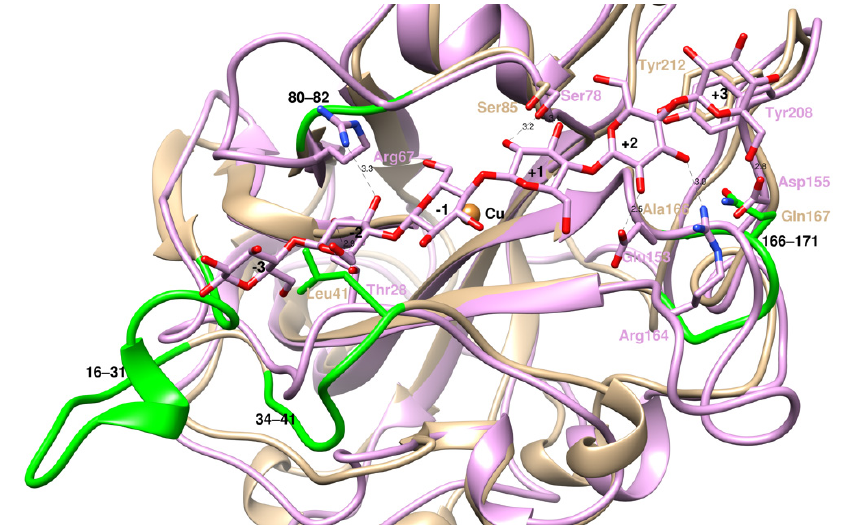
Figure 8. The active sites of n Ta AA9A (brown) and Cv AA9_A (pink; PDB id 6yde). Cellohexaose bound to Cv AA9_A is shown in stick representation. n Ta AA9A loops that show differences with corresponding loops in Cv AA9_A are colored in green and labeled. The Cv AA9_A residues that make hydrogen bond interactions with cellohexaose are shown as sticks and labelled. Tyr208 (Tyr212 in n Ta AA9A) that provides additional stabilizing interactions with the oligosaccharide is also shown. The structural equivalent residues in n Ta AA9 are depicted and labeled. Cv AA9_A residues Arg67 and Arg164 correspond to gaps in n Ta AA9A (Figure S3), and no structural equivalent residues are shown.